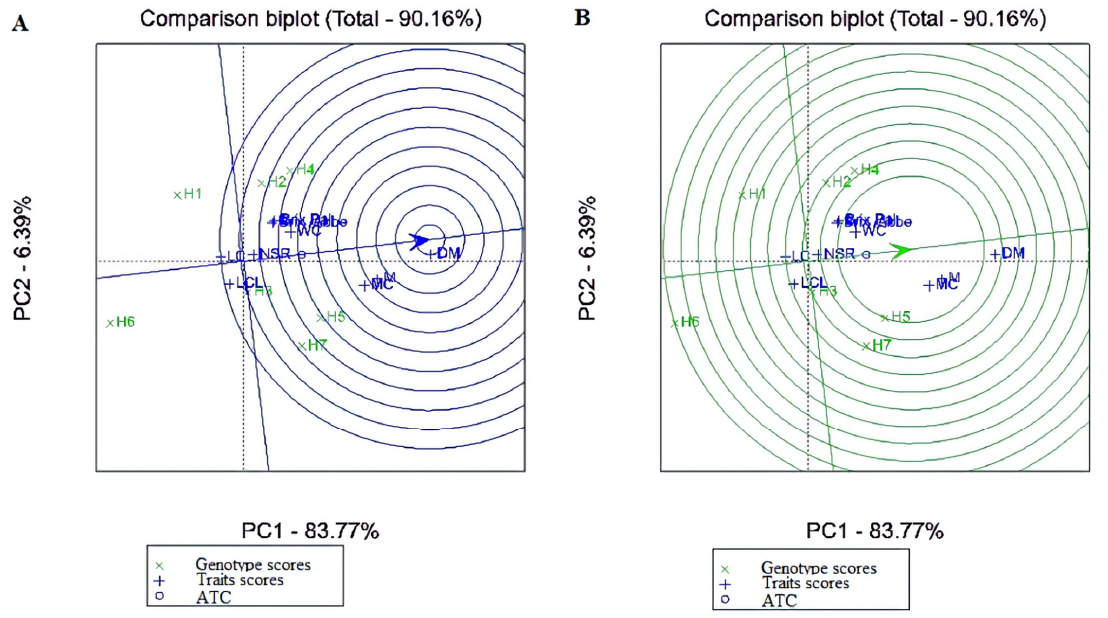
Figure 3. Biplot on different maize hybrids in non-irrigated treatment. ( A ) comparison based on the traits, ( B ) comparison based on the genotype. Ear length (LC), net ear length (LCL), ear weight (WC), number of kernel rows (NSR), Brix/Atago Pal-1, Brix/Abbe, soil moisture content (M), dry matter content of cob (DM), moisture content of cob (MC). (H1: Noa, H2: Dessert R78, H3: Dessert R72, H4: Messenger, H5: SF1379, H6: Honey, H7: GSS5649). DMC, Brix / Atago Pal-1, Brix / Abbe and soil moisture content had maximum stability